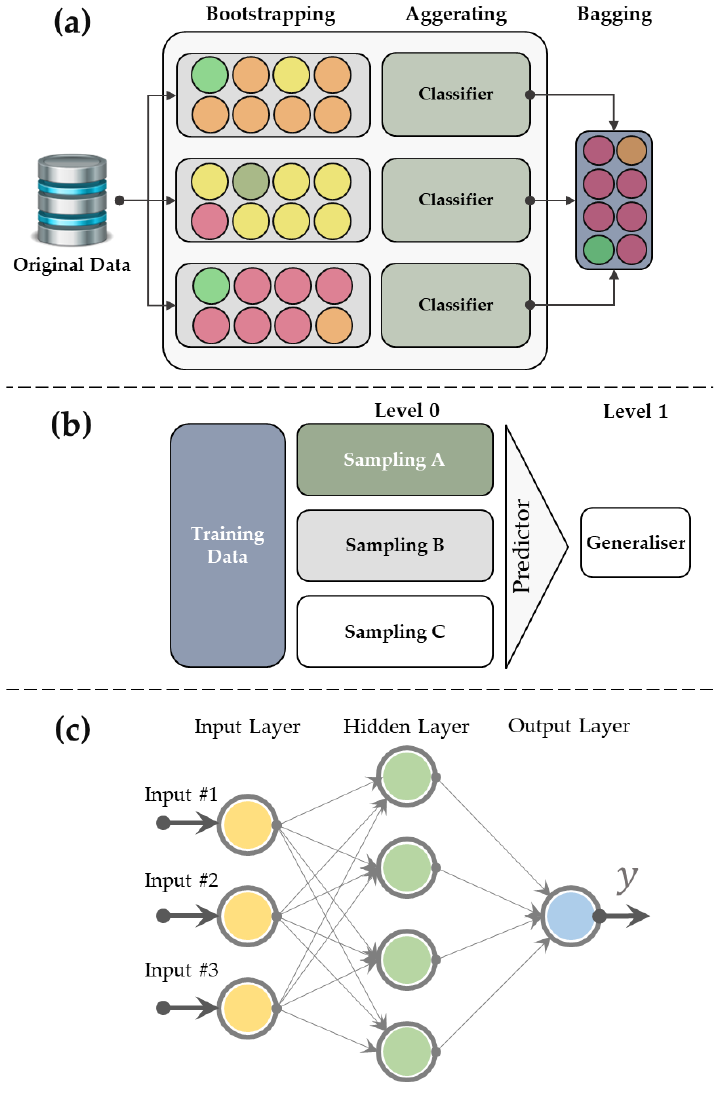
Figure 6. The structure of applied machine learning computations in the study based on ( a ) Meta Bagging ( b ) Meta Random Committee, and ( c ) Functions Multilayer Perceptron.